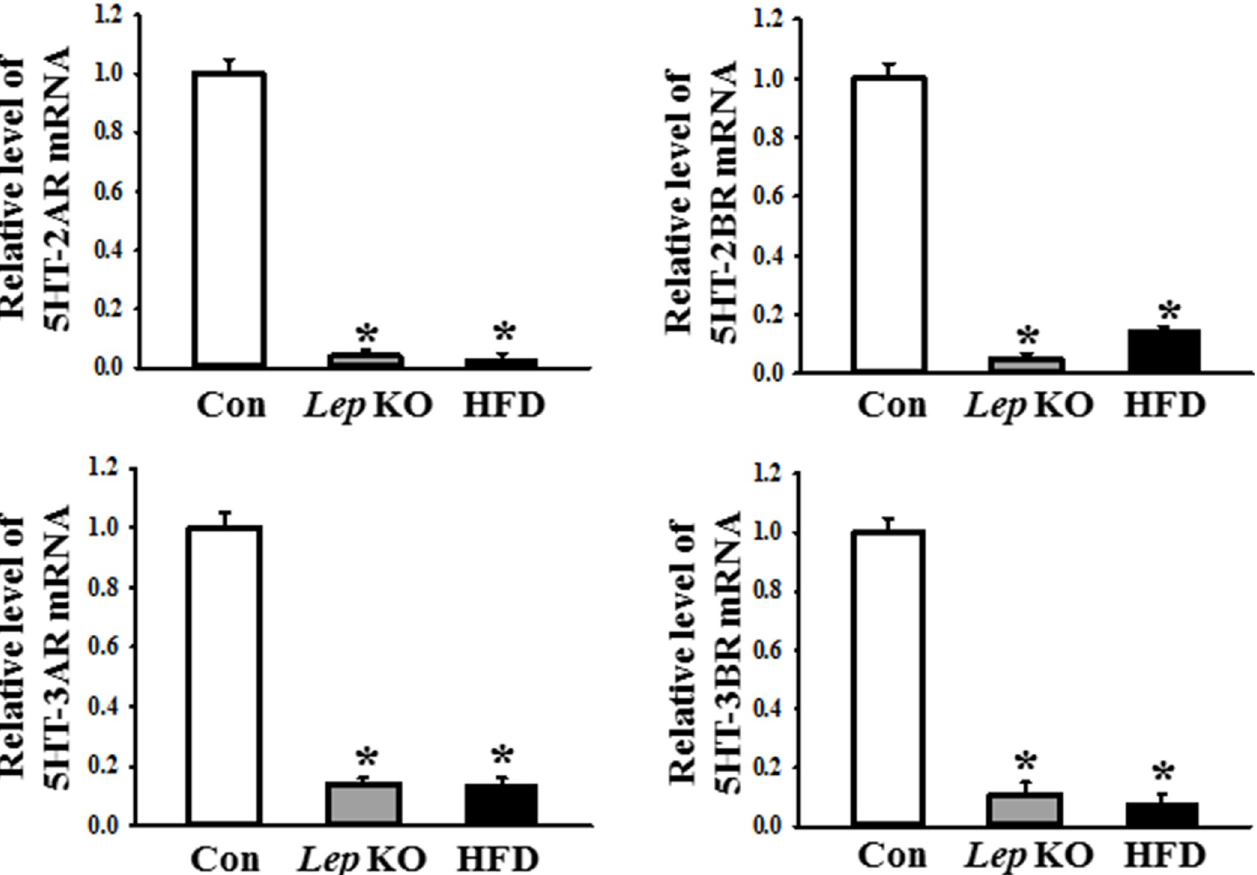
Fig 9. Expression of 5HT-2AR, 2BR, 3AR, and 3BR mRNA in the mid colon. The levels of four serotonin receptors mRNA in the total mRNA of the mid colon were measured by RT-qPCR using the specific primers. The mRNA levels of three genes were calculated based on the intensity of β -actin as an endogenous control. Three to five mices per group were used to prepare the total RNA. The RT-qPCR analyses were assayed in duplicate for each sample. The data are reported as the mean ± SD. � indicates p < 0.05 compared to the Con group. Abbreviations: Con, Control group; Lep KO, Leptin knockout mice; HFD, High fat